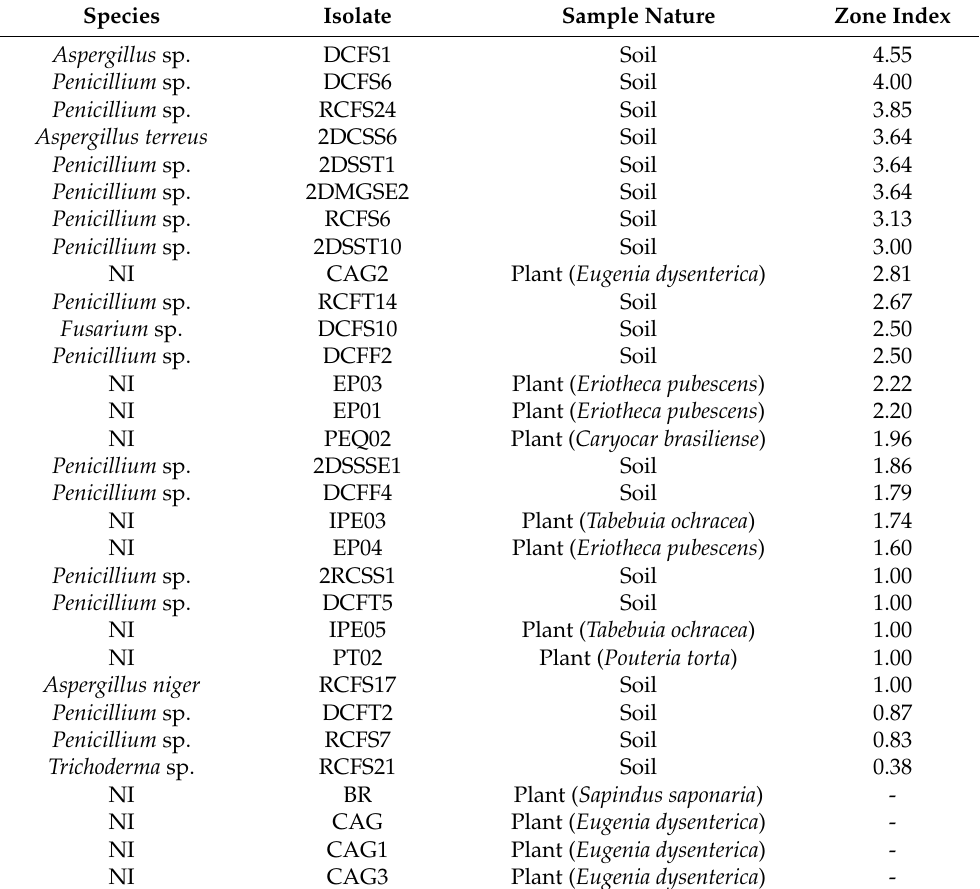
Table 3. Zone index values for the isolates obtained from Brazilian Savanna samples using phenol red as indicator representing their extent of crude L -asparaginase production after 48 h of incubation. Species Isolate Aspergillus